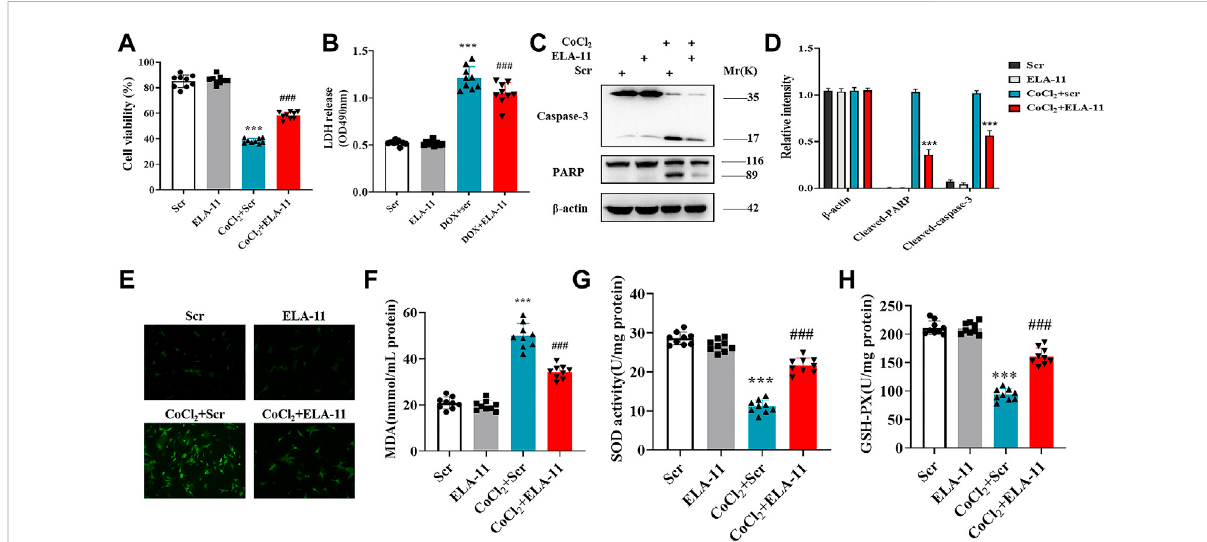
FIGURE 5 ELA-11 protected cardiomyocytes against oxidative stress-induced apoptosis in CoCl 2 model. (A) Cell viability in CoCl 2 -induced cardiomyocyte model. (B) LDH release in CoCl 2 -induced cardiomyocyte oxidative stress injury (N = 9 per group). (C,D) The expression of PARP and caspase-3 in CoCl 2 -induced cardiomyocyte oxidative stress injury by western blot. (E) Representative photographs of ROS production in CoCl 2 -induced cardiomyocyte oxidative stress injury. (F – H) Detection of MDA production, SOD activity and GSH -PX release in CoCl 2